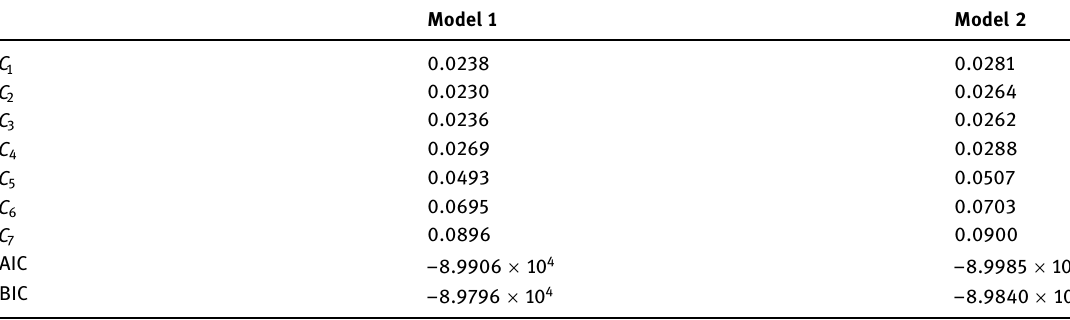
Table 4: Akaike ( AIC ) , Bayesian information criterion ( BIC ) , and RMSE for Models 1 and 2